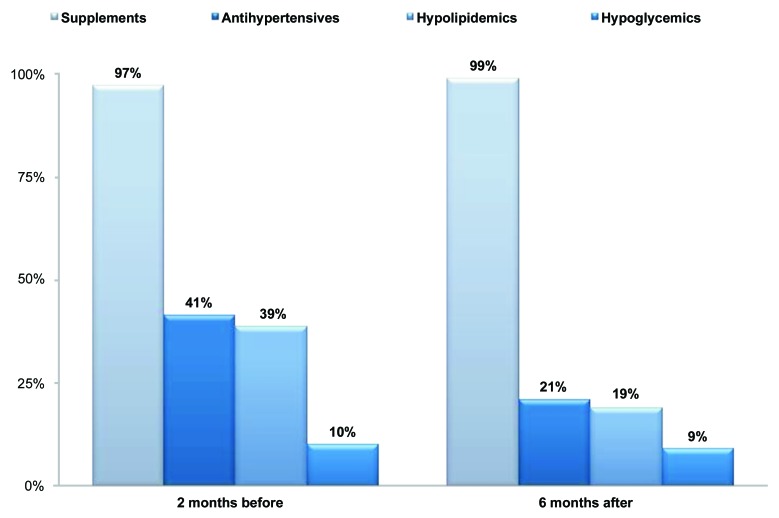
Most frequent medications.